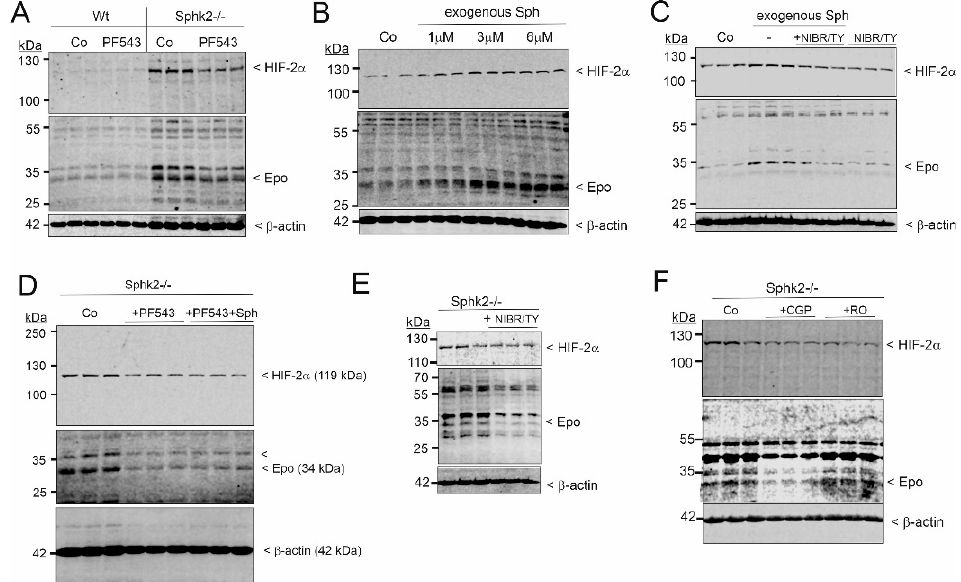
Figure 6. Exogenous sphingosine and the Sphk1 inhibitor PF543 affect HIF-2 α and Epo protein levels in primary cultures of mouse fibroblasts. ( A ): Wildtype (Wt) and Sphk2 − / − renal fibroblasts were incubated for 16 h with serum-free DMEM prior to stimulation for 24 h with 1µM PF543. ( B ) Wt fibroblasts were treated for 24 h with increasing concentrations of exogenous sphingosine. ( C ) Wt fibroblasts were treated for 24 h with 3 µM sphingosine in the absence ( − ) or presence of 10 µM each of NIBR-0213 plus TY52156. ( D ) Sphk2 − / − renal fibroblasts were pretreated for 4 h with 1 µM of PF543 and then treated for 24 h with 3 µM sphingosine. ( E ) Sphk2 − / − cells were treated for 24 h with 10 µM NIBR-0213 and TY52156. ( F ) Sphk2 − / − cells were treated for 24 h with 100 nM CGP41251 or 1 µM RO-318220. Protein was analyzed by immunoblotting using antibodies against HIF-2 α , Epo, or β -actin. Corresponding bands were evaluated by using Image Studio Lite software (version 3.1, LI-COR Biosciences, Lincoln, NE, USA), normalized to β -actin, and are presented in Figure S9. Similar to hypoxia, the iron chelating drug deferoxamine [51] also increased HIF-2 α and Epo protein levels and this effect was blocked by the Sphk1 inhibitor PF543 and the combined antagonism of S1P 1 and S1P 3 (Figure